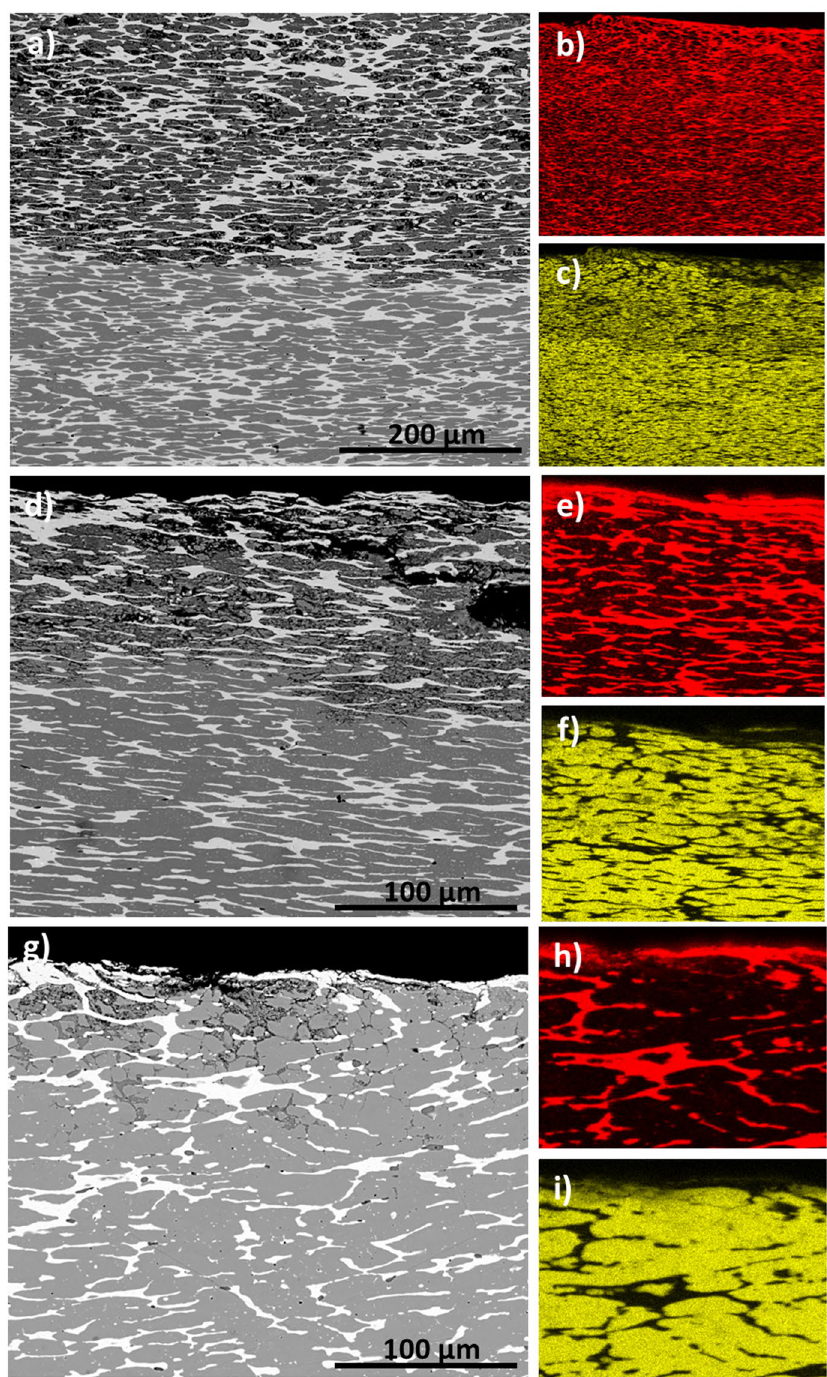
Figure 3. BSE images showing the microstructures of Antoninianus coins ( a,d,g ) C, G and H and their X-ray maps of ( b,e,h ) Ag and ( c,f,i )